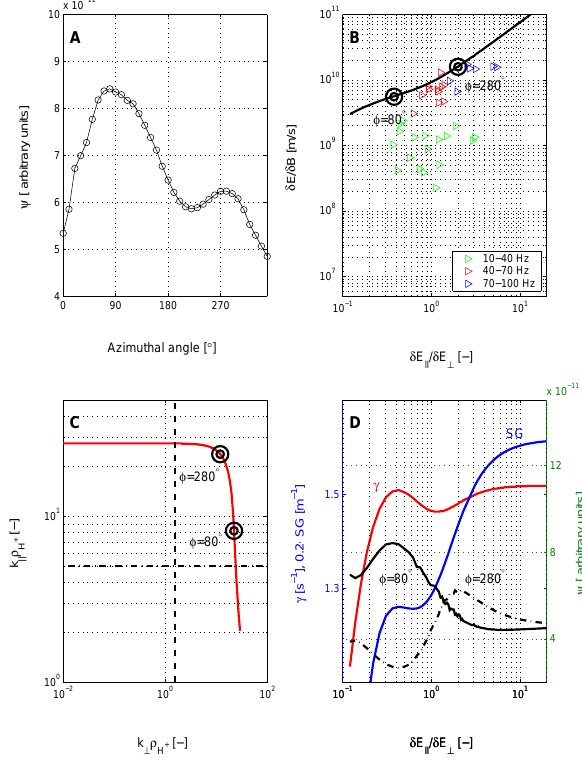
Fig. 13. Panel (A) presents the WDF versus the azimuthal angle. Two maxima can be identified. Panel (B) shows the location of these maxima on a constant frequency curve (50Hz) plotted versus δ E/ δ B and δ E || / δ E ⊥ g . The data points are the same as in Fig. 11. The WDF maxima are also viewed on a constant frequency contour in ( k || , k ⊥ ) -space (panel C ). Panel (D) is a comparison between the WDF at φ =80 ◦ and φ = y80 ◦ (solid and dashed-dotted black lines) and the predicted temporal (red) and spatial (blue) growth